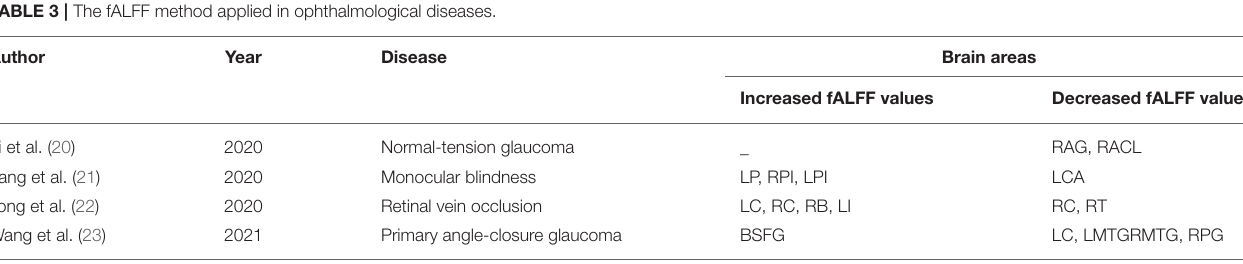
TABLE 3 | The fALFF method applied in ophthalmological